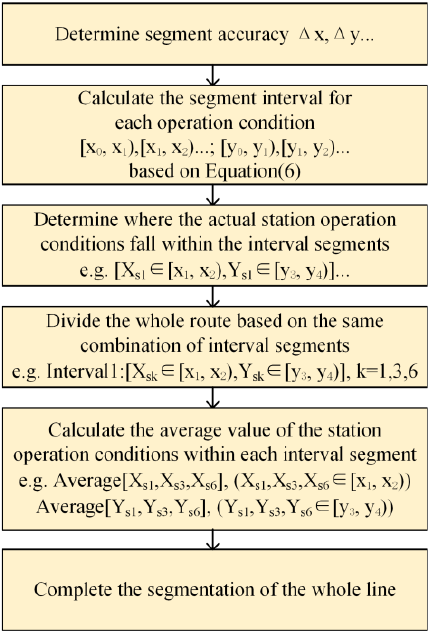
Figure 9. The flow chart of OIS of the whole line.